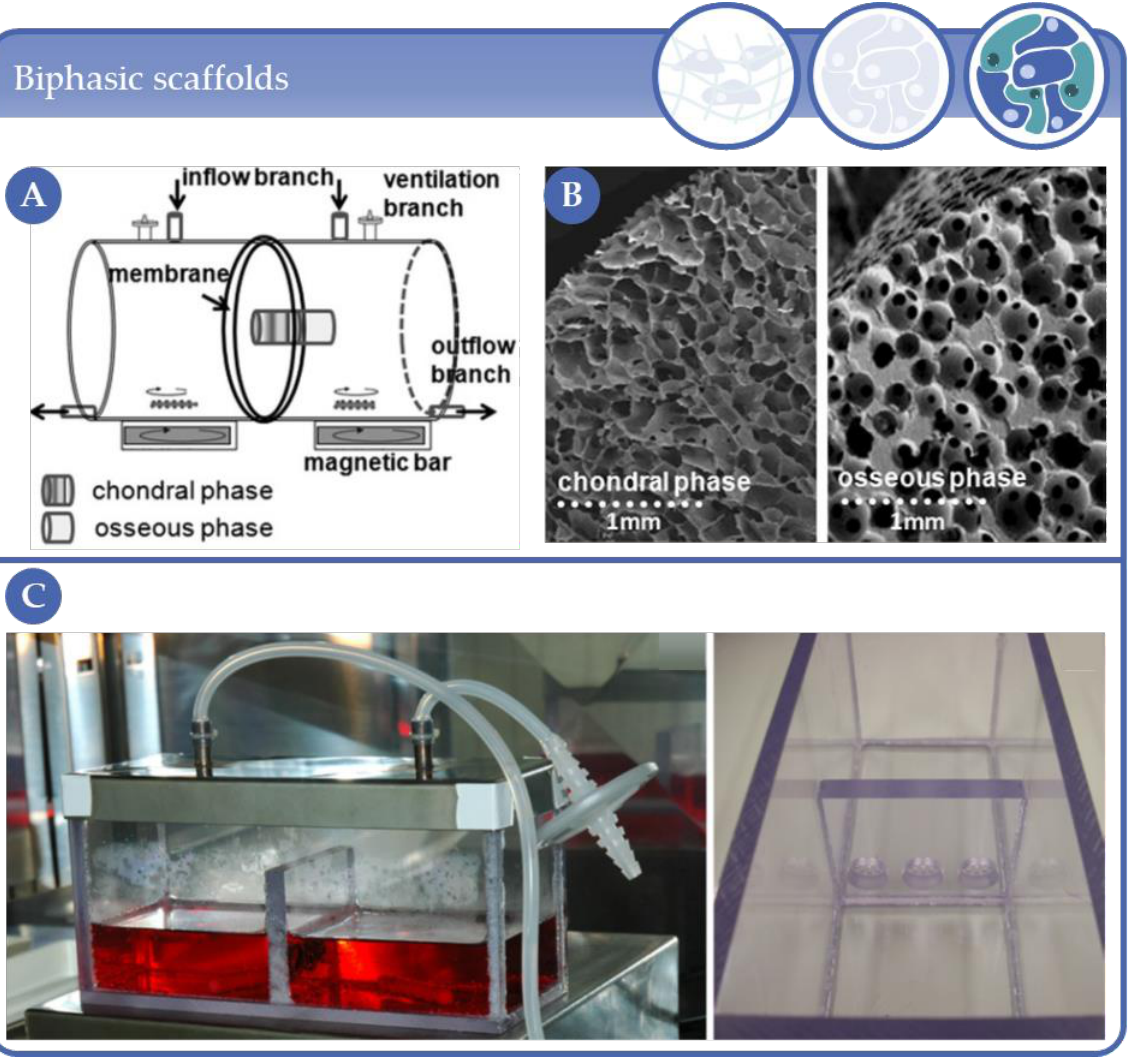
Figure 23. ( A ) Stirred and fluidic superfusion bioreactor of Liu et al. ( B ) Chondral (left) and osseous phase (right) of the biphasic scaffold used in (A). Reprinted from [204] with permission of Springer Nature ( C ) Bioreactor system of Mahmoudifar and Doran consisting of two separate culture chambers containing osteogenic respectively chondrogenic medium (left). Up to three triplicate PGA disk scaffolds can be mounted between the two chambers (right). This allows the surface of the scaffolds to contact the two differentiation media for development of osteochondral tissues. Reprinted from [205] with permission of John Wiley and Sons.